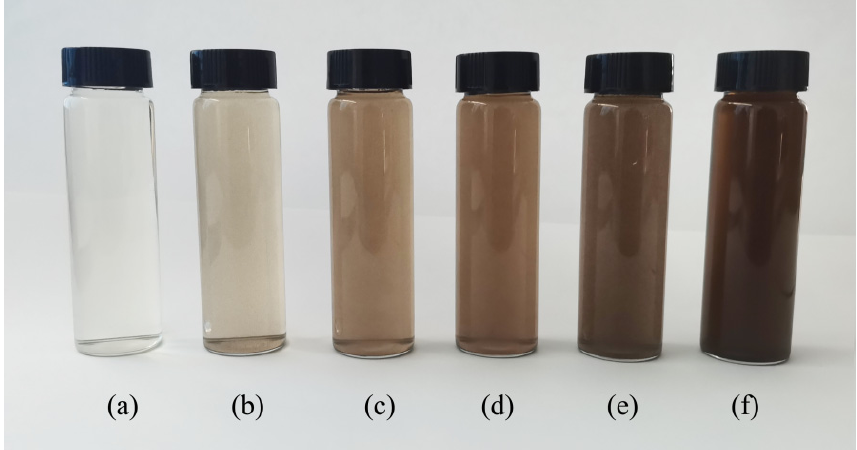
Figure 1. Dispersing effect of different proportions of GO in a 2% superplasticizer aqueous solution: ( a ) 0.00%; ( b ) 0.02%; ( c ) 0.04%; ( d ) 0.05%; ( e ) 0.06%; ( f ) 0.08%. ( a ) 0.00%; ( b ) 0.02%; ( c ) 0.04%; ( d ) 0.05%; ( e ) 0.06%; ( f )